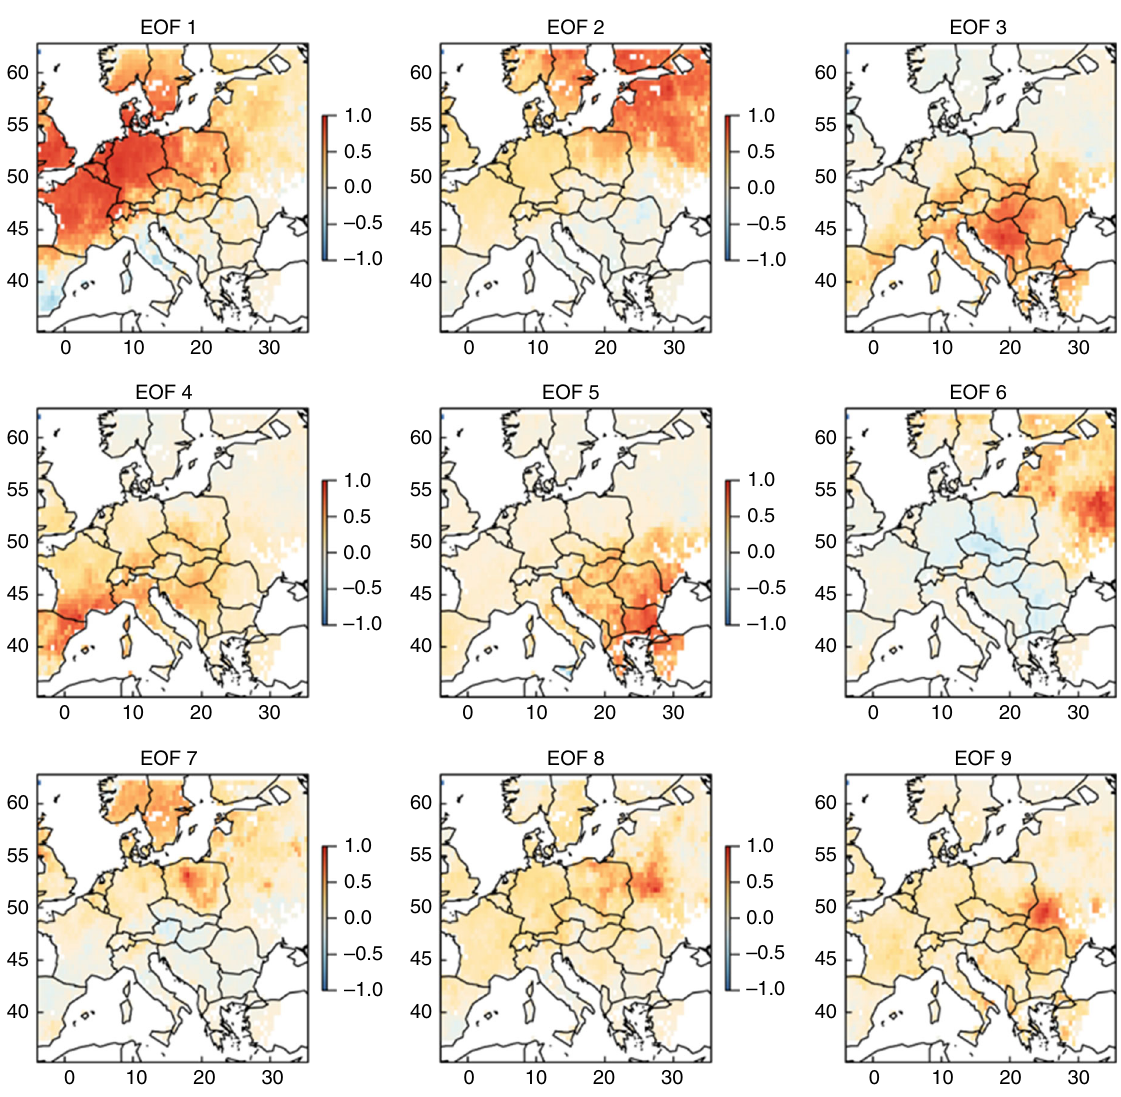
Fig. 7 Empirical orthogonal functions. Spearman ’ s linear correlation coef fi cients between scPDSI and the time series derived by empirical orthogonal